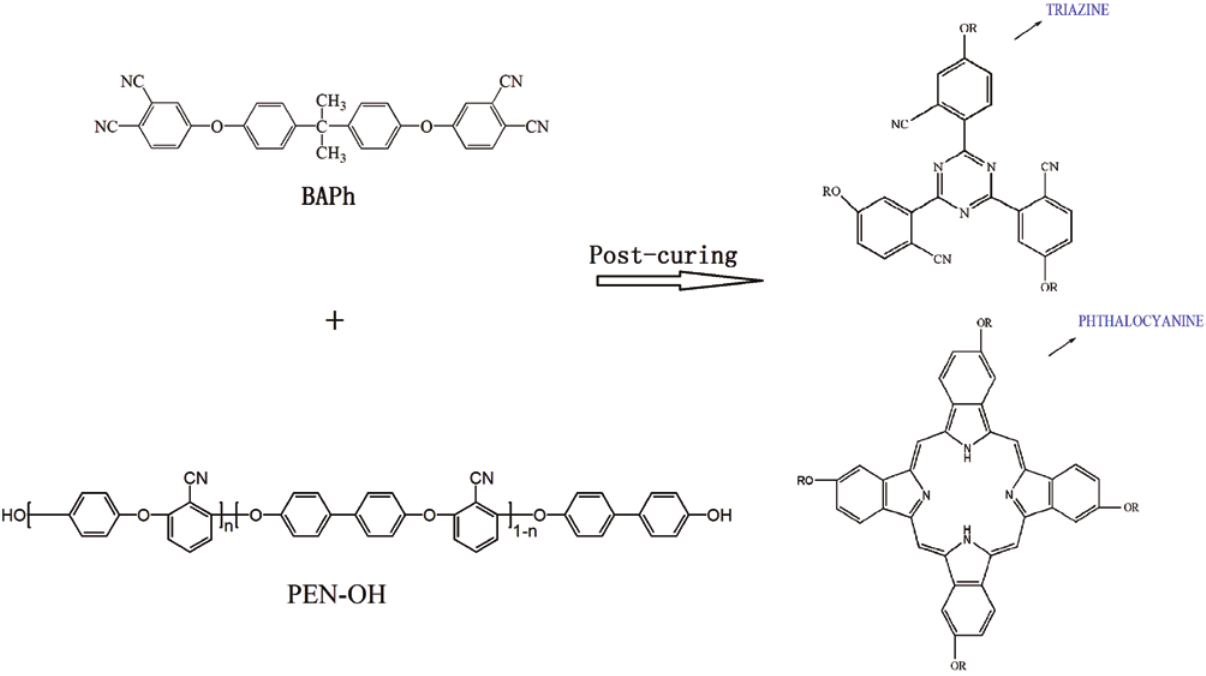
Figure 1: Chemical structures of BAPh, PEN-OH, and heterocyclic